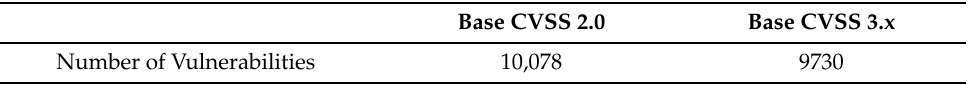
Table 7. Comparison of the number of vulnerabilities detected according to the selected standard for environment C.